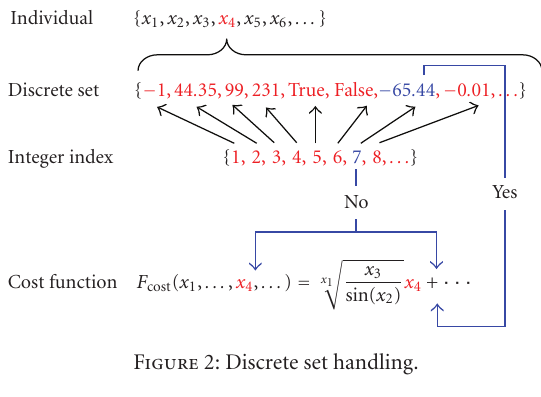
Figure 2: Discrete set handling.